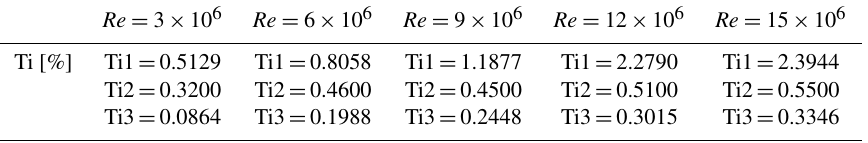
Table 2. Test matrix to analyze the effect of transition model at different Reynolds numbers and free-stream turbulence intensities (Ti) through comparison against experimental data for the DU00-W-212 airfoil from the AVATAR project (Ceyhan et al., 2017a). Three turbulence intensities (Ti1, Ti2, Ti3) are tested at each Reynolds number.